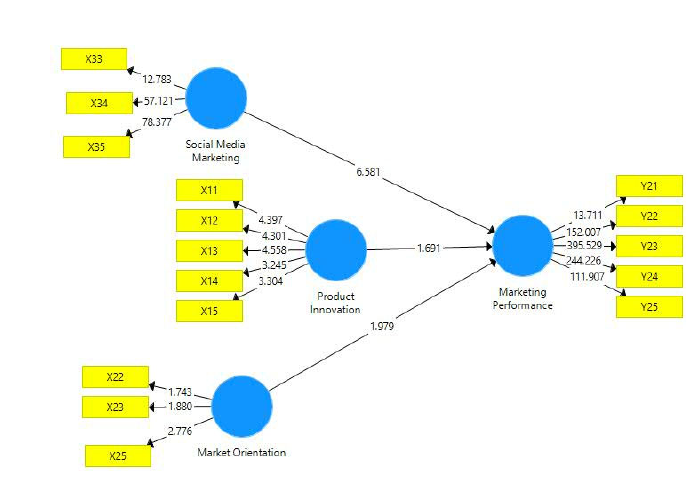
Fig. 3. Hypotheses